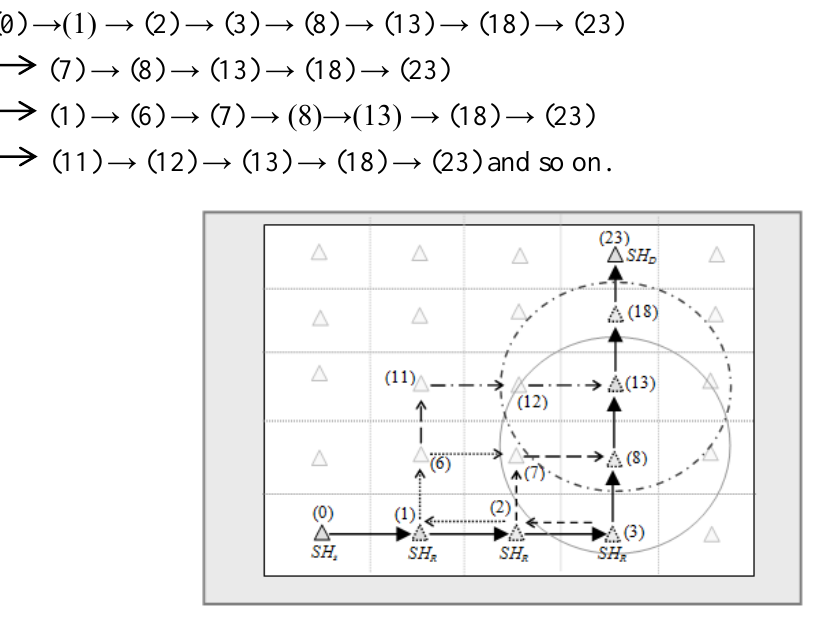
Figure 5. Some of the possible alternate routes from SHs → SH D